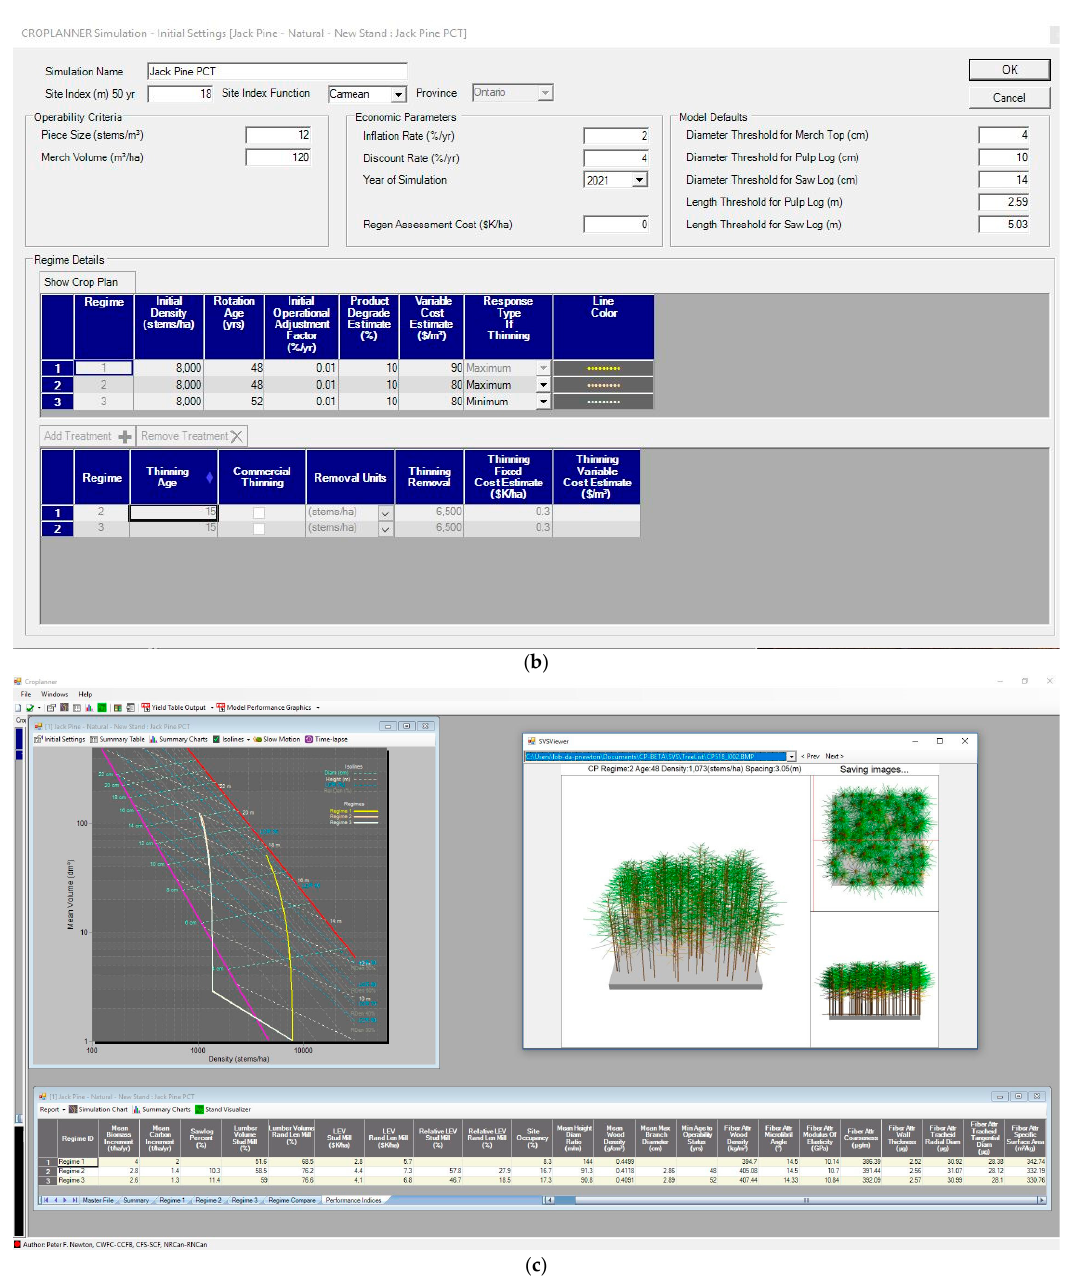
Figure 3. Exemplifying the automated crop plan selection capability of the CP DSS in regard to determining the optimal PCT regime within natural-origin stand-types (jack pine) via the deployment of the operability optimizer: ( a ) input GUI dialog panel inclusive of end-user required input which consisted of the specification of (i) stand-type, simulation identifier (name), site index and associated function, initial density, maximum rotation age, operational adjustment factor, product degrade, variable cost, thinning response model type, merchantable limits, and operability targets, (ii) treatment specifics and constraints (range of treatment ages, thinning density searching interval (algorithmic-based), minimum removal densities (operational-based), fixed treatment cost, minimum post-thinning residual density; maximum height/diameter ratio), and (iii) multivariate selection priority weights (tree size, operability and economic efficiency); ( b ) auto-populated input GUI dialog panel returned from the optimizer with the selected optimal PCT-based crop plan inclusive of regime-specific revised rotation ages corresponding to the minimum age at which the specified operability status is attained, thinning response model utilized, and the selected optimal time of treatment and associated thinning removal density; and ( c ) resultant optimal crop plans presented within traditional SDMD graphic, tabular summary of rotational performance metrics, and an example stand visualization graphic at rotation (Regime 2). Refer to Summary Report SM2 (Supplementary Material) for a complete account of the output produced for this set of crop